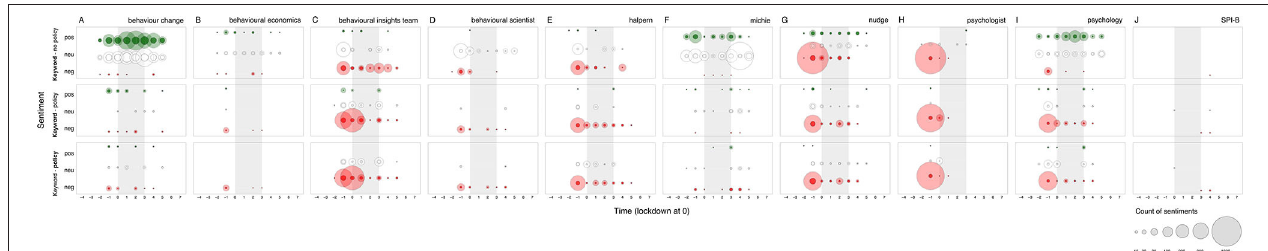
FIGURE 12 | Twitter articles—sentiment toward the 10 primary keywords separated by sentences that do (top) and do not refer to policy application (middle), and sentiment toward policy contexts of keywords (bottom) over the 8 two-week time period surrounding the first British national lockdown of 2020. Sentiments are represented in counts of positive ( + 1 or + 2), neutral (0), and negative ( − 2 or − 1) bubbles over time, in green, white and red respectively. The area of the bubbles is proportional to the count of sentiments toward the keyword. Full-color bubbles represent sentiments in original tweets only; shaded-color bubbles represent sentiments accounting for retweets. (A) behaviour change (concept), (B) behavioural economics (discipline), (C) behavioural insights team (named actor), (D) behavioural scientist (unnamed actor), (E) halpern (named actor), (F) michie (named actor), (G) nudge (concept), (H) psychologist (unnamed actor), (I) psychology (discipline), (J) SPI-B (names actor).